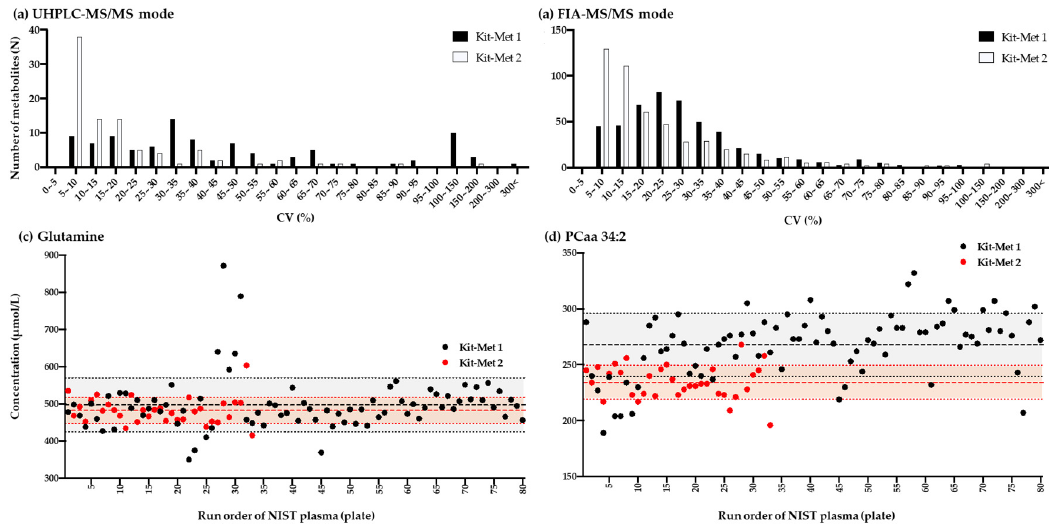
Figure 2. Frequency of the detected metabolites along with the range of the coefficient of variation (CV, %) in the NIST plasma samples in UHPLC-MS/MS mode ( a ) and FIA-MS/MS mode ( b ) by Kit-Met 1 (black bar) and Kit-Met 2 (white bar) and the single plots of glutamine ( c ) and PCaa 34:2 ( d ) among 80 plates evaluated by Kit-Met 1 (black dot) and 33 plates evaluated by Kit-Met 2 (red dot). The thick-dot lines are median concentration of 80 plates by Kit-Met 1 (black) and 33 plates by Kit-Met 2 (red). The filling thin-dot line areas are median concentrations ±